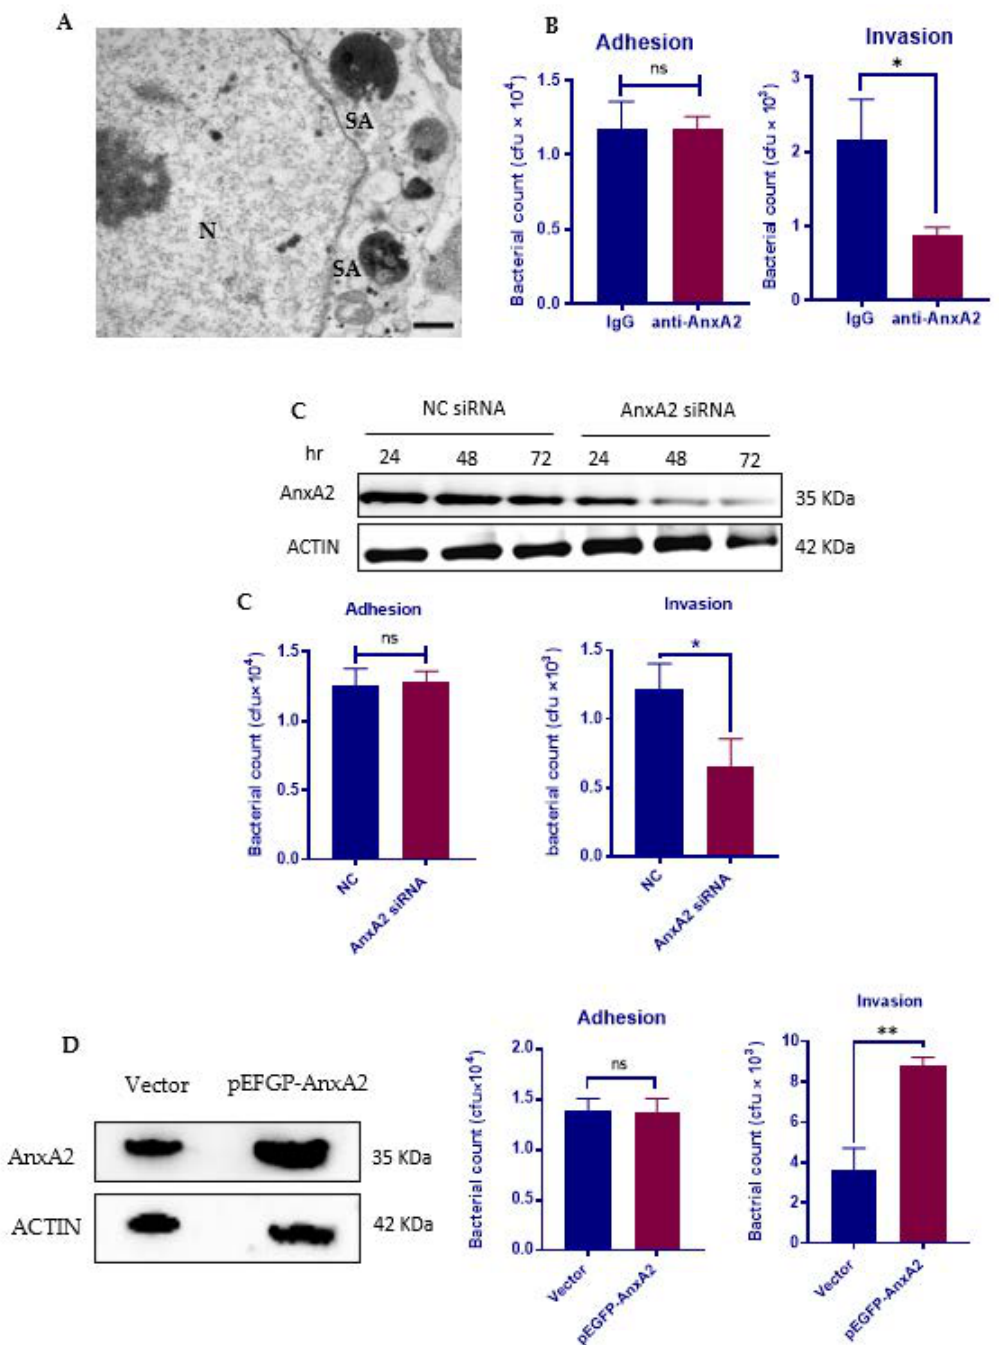
Figure 1. AnxA2 mediates the invasion of S. aureus . ( A ) Transmission electron micrograph showing internalization of a clinical isolate of S. aureus (Clin-SA) into MAC-T. Two engulfed bacteria (boxed) are displayed at high magnification. Photograph represents a 1 h co-culture of cell monolayer with Clin-SA at a MOI of 50. N: nucleus; C: cytoplasm. Scale bar: 500 nm. ( B – D ) Effect of AnxA2 on S. aureus adhesion to and uptake by MAC-T cells. MAC-T cells were pre-incubated with anti-AnxA2 antibody (17.5 µ g/mL) or human IgG (17.5 µ g/mL) for 2 h to block AnxA2 function ( B ), treated with AnxA2 siRNA for 72 h to knock down the expression of AnxA2 ( C ), or transfected with a pEGFP-AnxA2 plasmid for 48 h to overexpress AnxA2 ( D ) prior to Clin-SA infection (MOI: 50). The adhesion and invasion assays were performed after incubation of MAC-T with bacteria for 1 h. Dates are mean values ± s.d. of three replicates. * p < 0.05; ** p < 0.01; ns: no significant